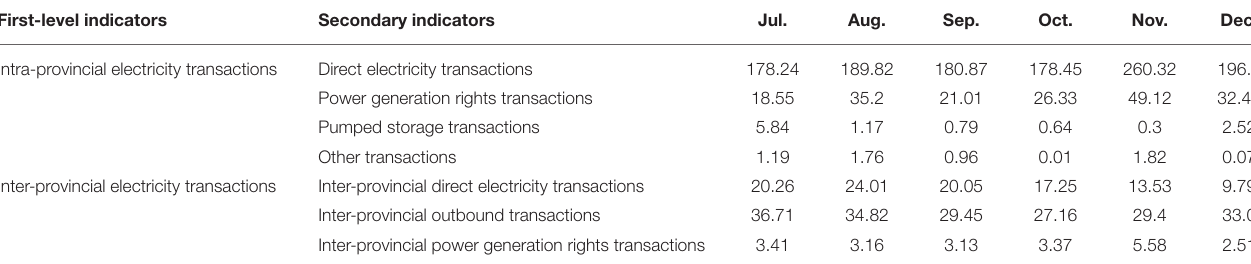
TABLE 1 | Transaction quantity of different transaction types between July and December 2019 (unit: TW · h). First-level indicators